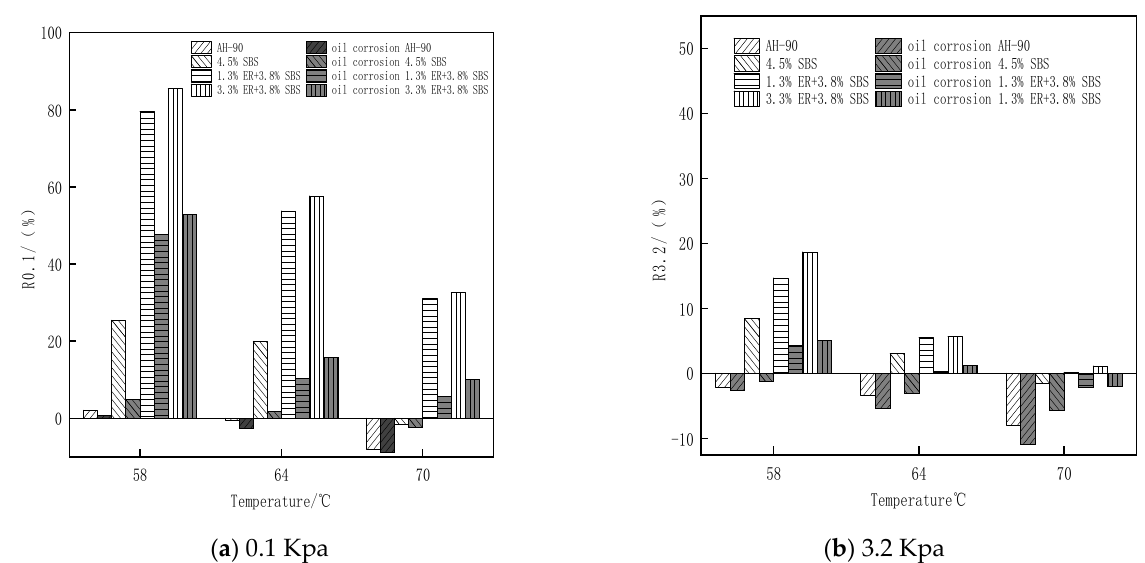
Figure 13. Average strain creep recovery rate of each bitumen with temperature under different stresses.